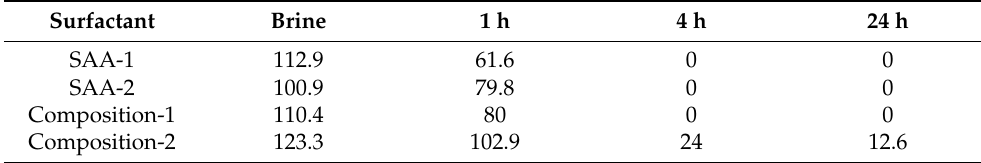
Table 7. Measurement of the contact angle for Vereian horizon.